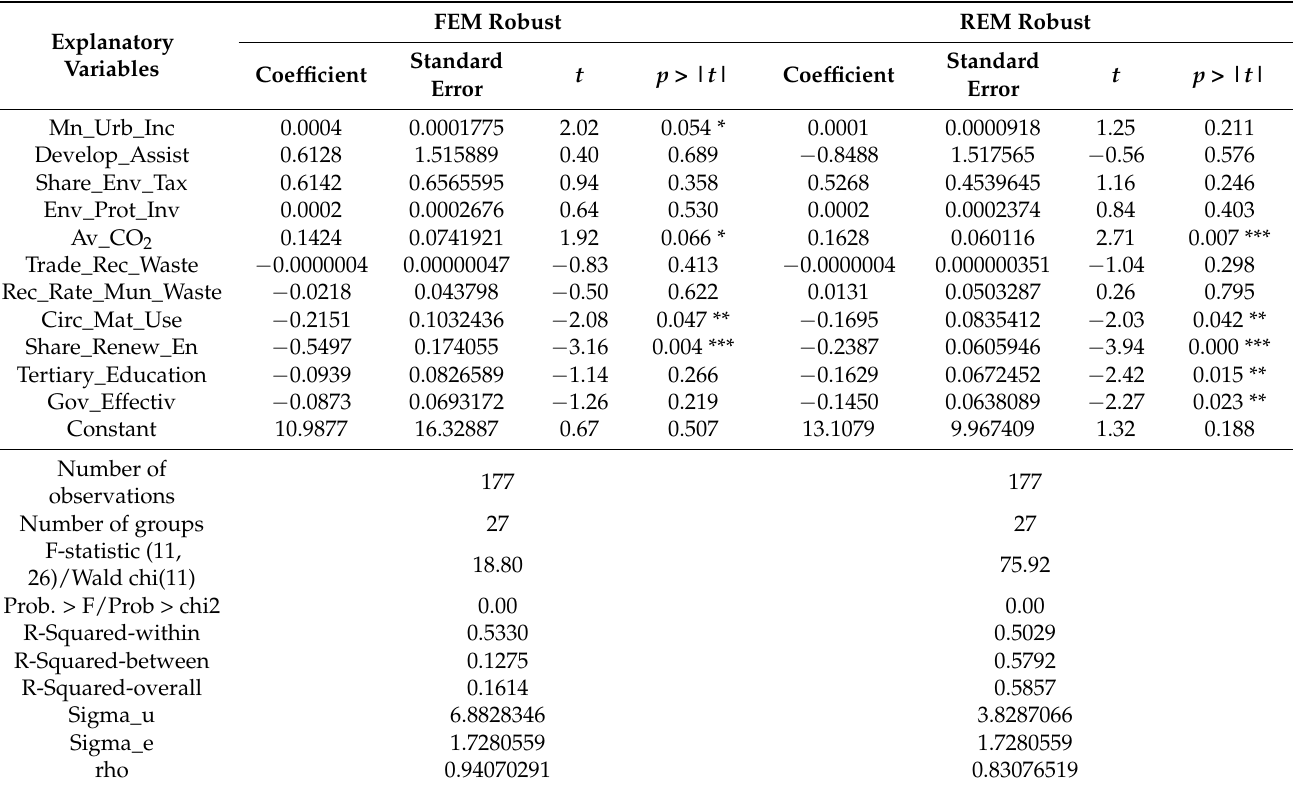
Table 8. The statistical significance of the factors and the coefficients for FEM-robust and